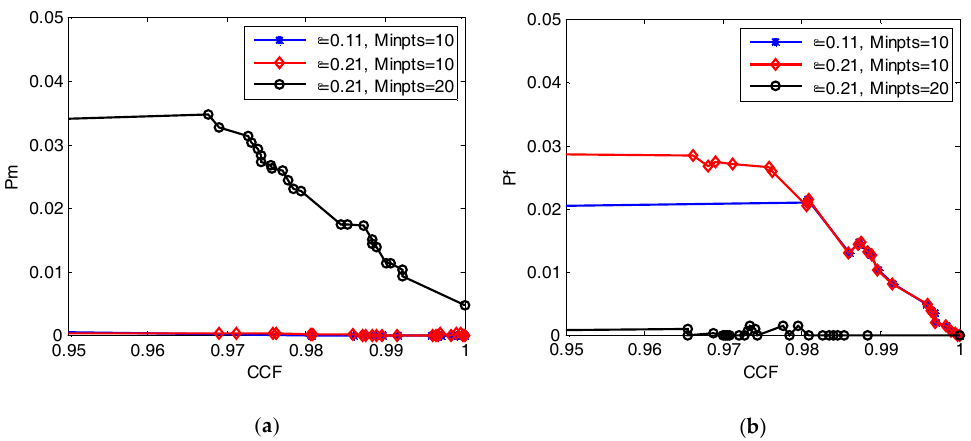
Figure 7. P m and P f predicted by HMM for NE TV (614-698MHz) frequency band. ( a ) The relational P predicted by HMM for NE TV (614-698MHz) frequency band. ( a ) The P and Figure 7. f m graph between P m and CCF with di ff erent ε and MinPts. ( b ) The relational graph between P f and CCF P and CCF with different ε and MinPts. ( b ) The relational graph relational graph between with di ff erent ε and MinPts. m between f P and CCF with different ε and MinPts.